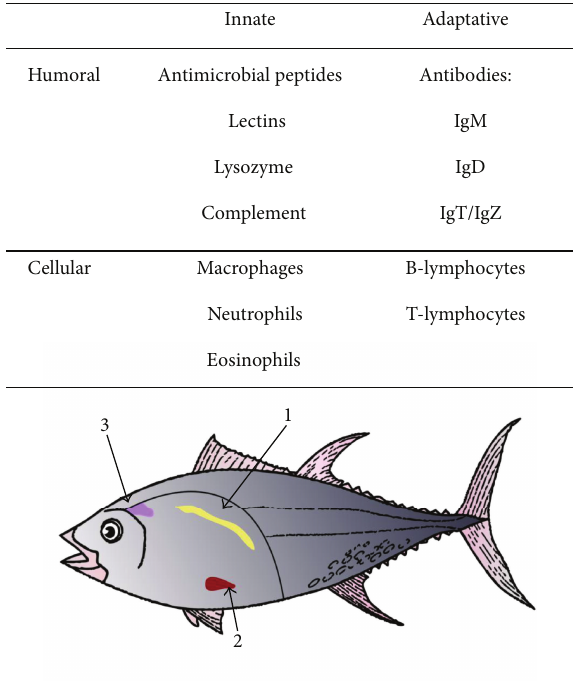
Figure 1: Main humoral, cellular, and anatomical components of the immune system in fishes. Fish lymphoid organs: pronephros (1), spleen (2), and thymus